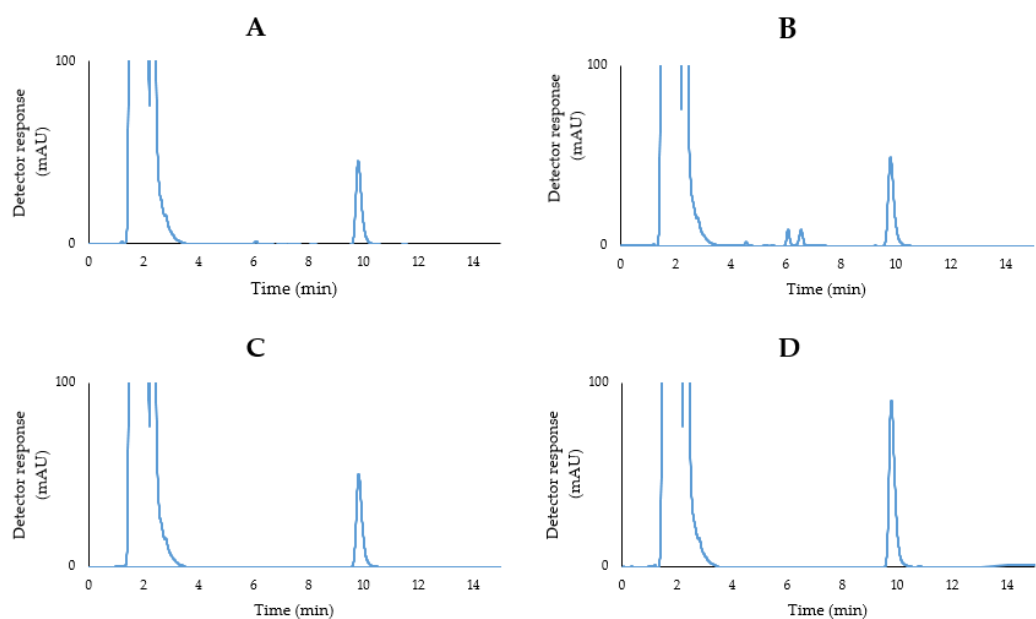
Figure 3. The HPLC chromatograms of forced degradation test. ( A ): 0.1 mol/L hydrochloric acid, ( B ): 0.1 mol/L of sodium hydroxide, ( C ): oxidative stress: 3% hydrogen peroxide, ( D ): high temperature.